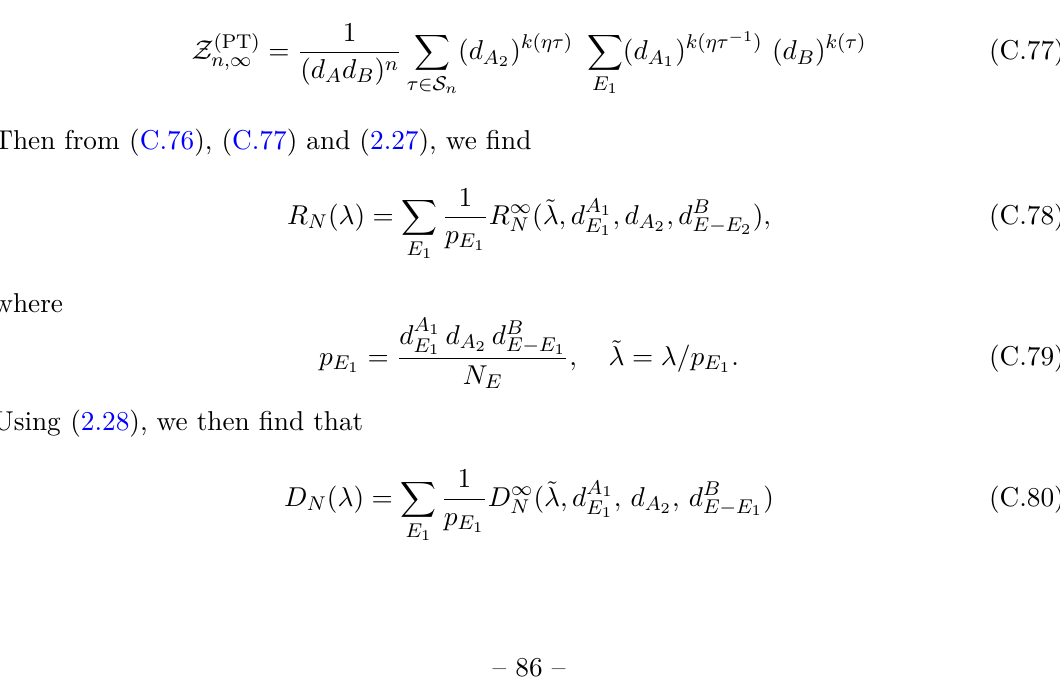
get set to some E which is summed over, 1 1 1